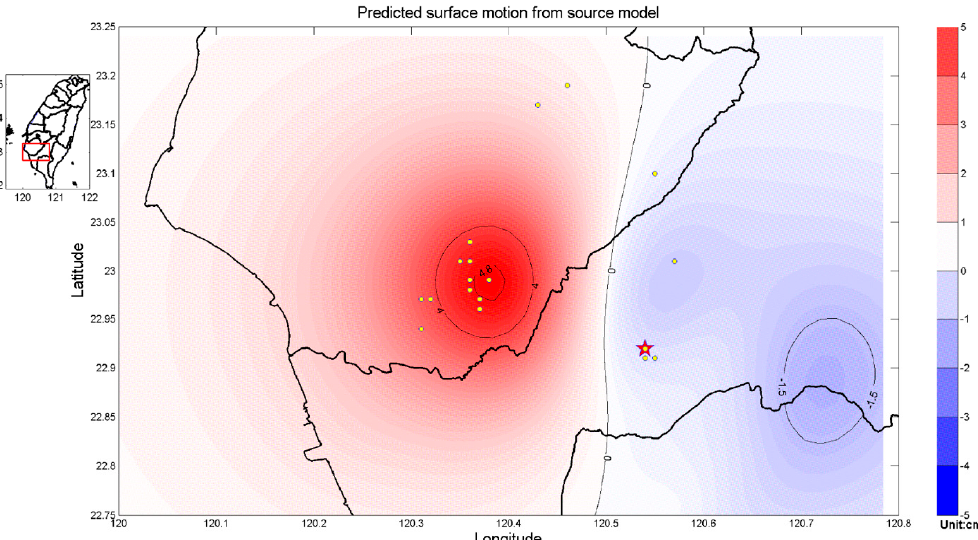
Figure 6. Predicted vertical surface displacements calculated using the proposed inverted model. The red star is the hypocenter, and the small yellow points represent aftershocks. Areas with high displacement values located northwest of the hypocenter indicate that the fault rupture extended from the hypocenter in the northwest direction along the seismogenic fault.